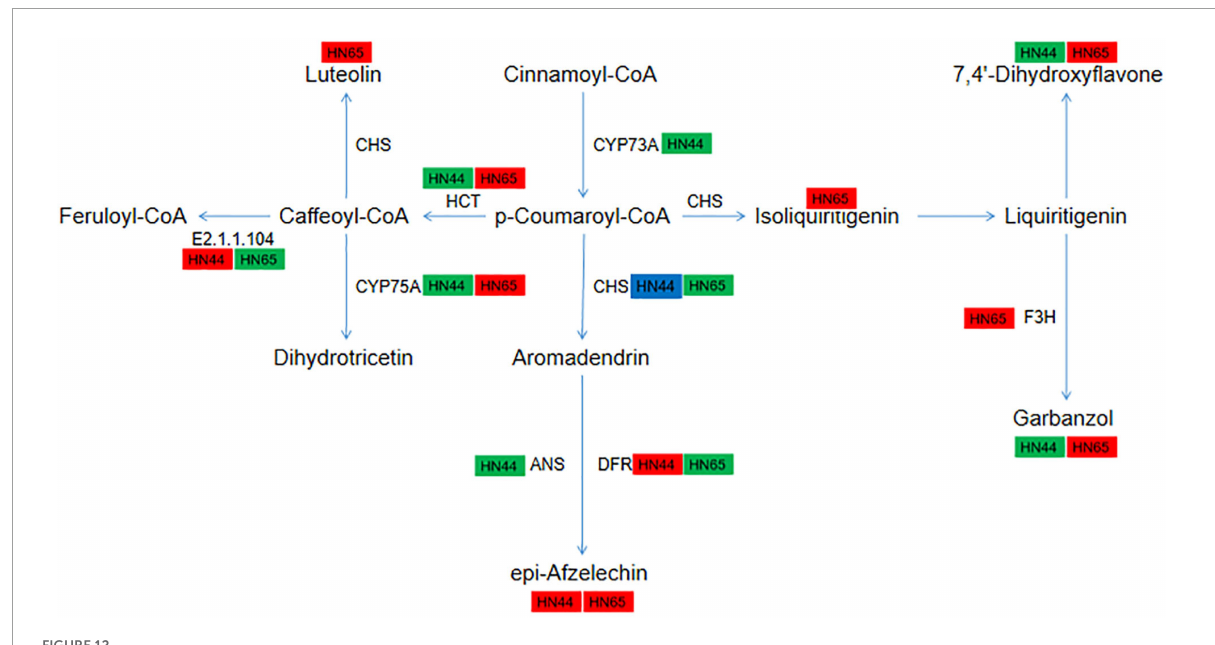
FIGURE12 Pathway diagram of flavonoid